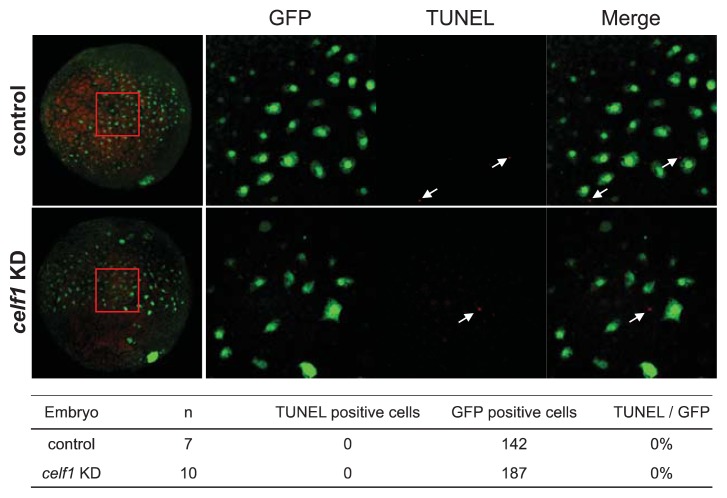
Cell death in zebrafish embryos at 90% epiboly stage. TUNEL assays were performed in Tg [sox17:GFP] embryos at 9 hpf. Green and red signals indicated GFP-expressing endoderm cells and TUNEL positive cells, respectively. Arrows marked TUNEL positive cells. Right panels were higher magnification images highlighting endoderm cells with the embryo (left panel). TUNEL signals were detected within the embryos, but we could not find TUNEL positive endoderm cells in control and celf1 KD embryos.